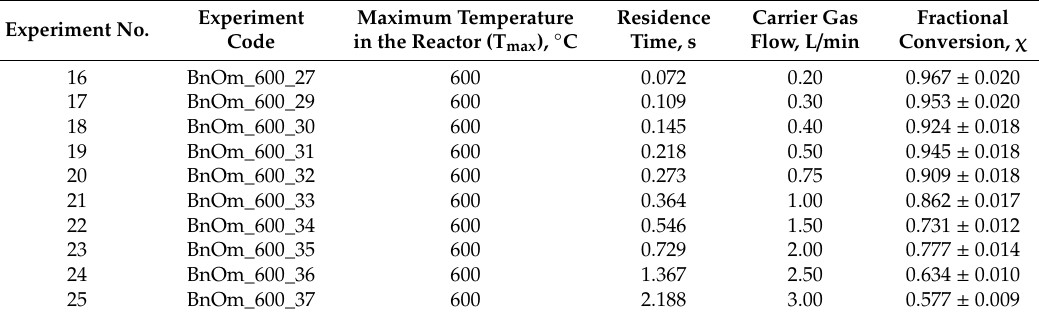
Table 4. Results of the kinetic measurements of O-methyl-N-cyclohexyl carbamate thermolysis (1b). Experiment No.